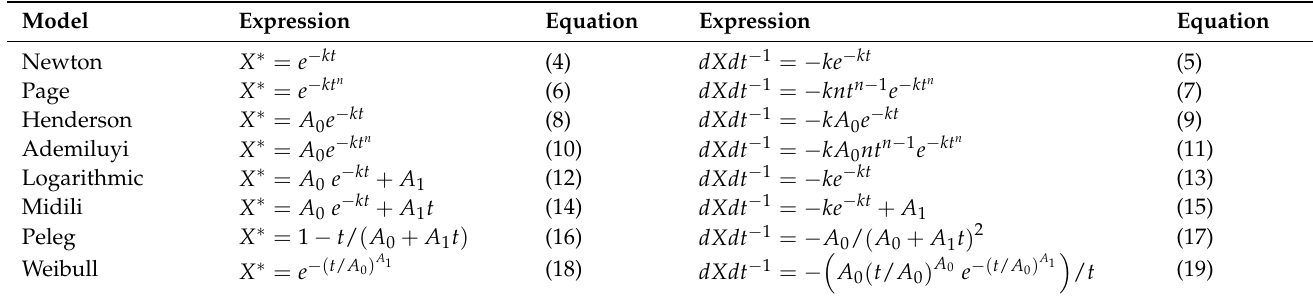
Table 1. Moisture ratio ( X* ) and drying rate ( dXdt − 1 ) expressions obtained from the semi-empirical models employed for modeling the drying behavior of wheat cv. ‘Pionier’.